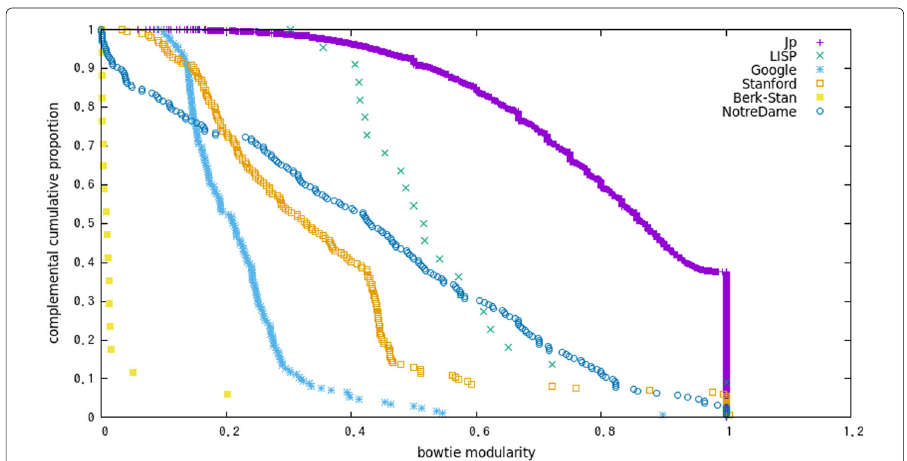
Fig. 12 bow-tie modularities of the four web networks and Japanese production network